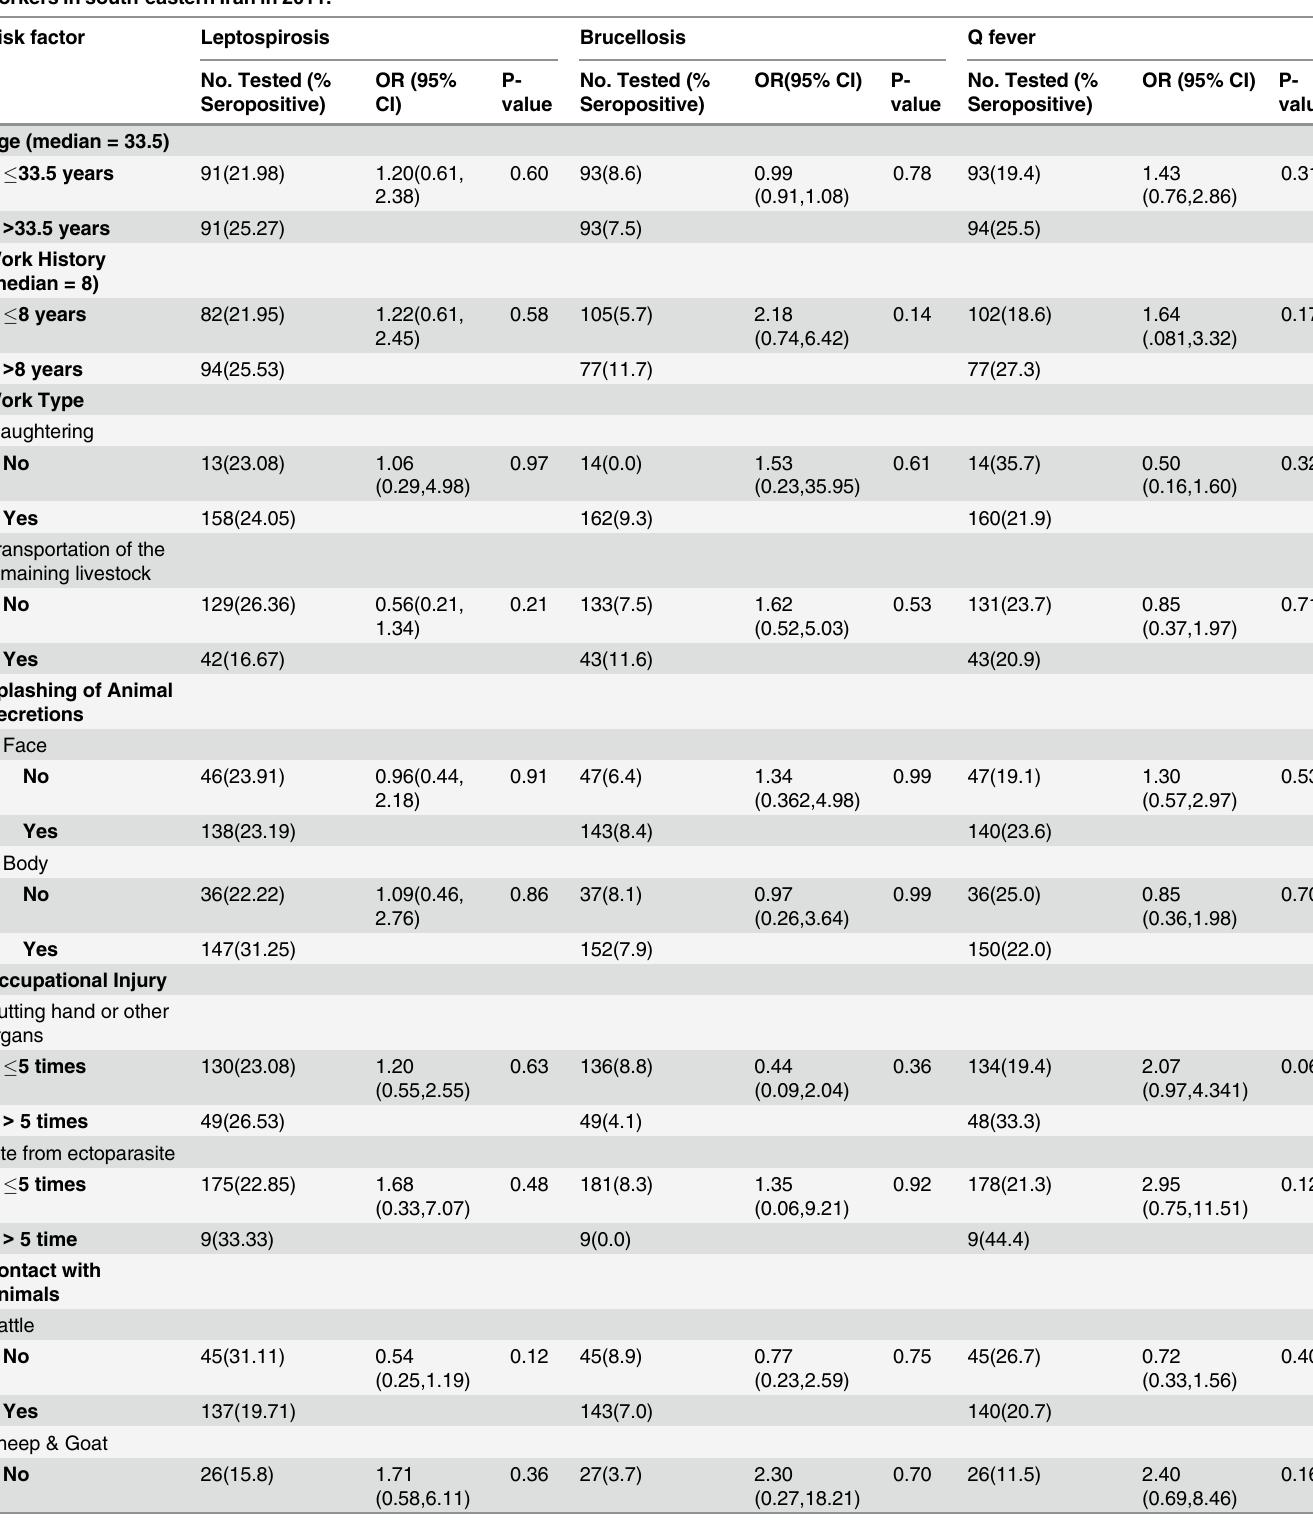
Table 1. Analysis of risk factors associated with the seroprevalence of leptospirosis, brucellosis and Q fever among butchers and slaughterhouse workers in south-eastern Iran in 2011. Risk factor